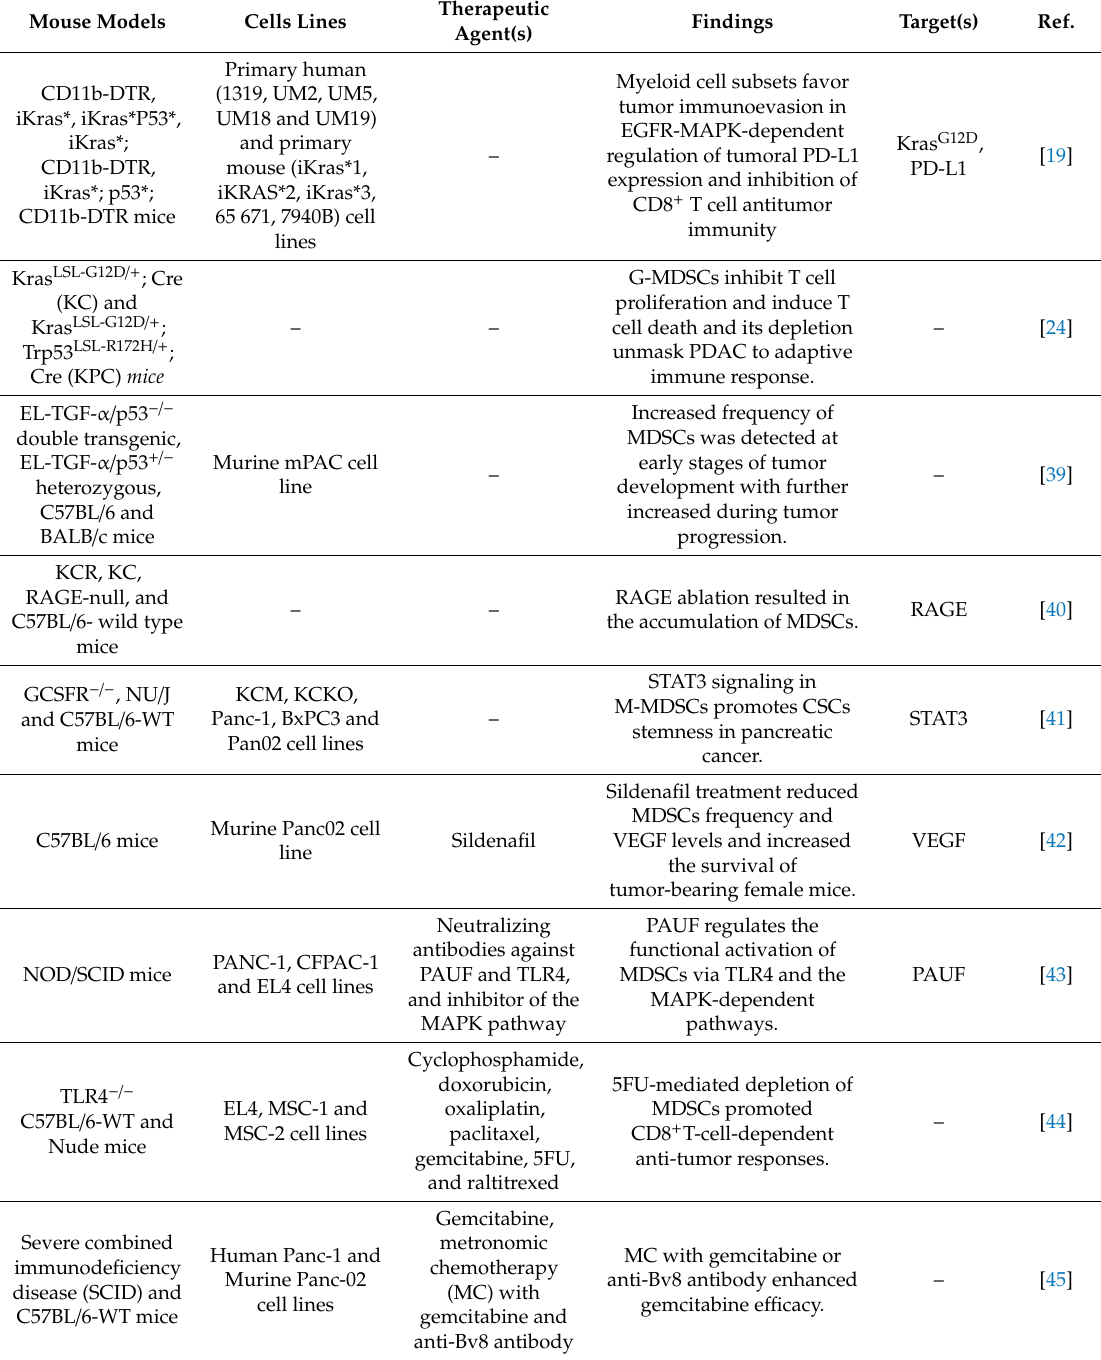
Table 2. Summary of preclinical studies defining the role of MDSCs in pancreatic cancer and / or therapy e ffi